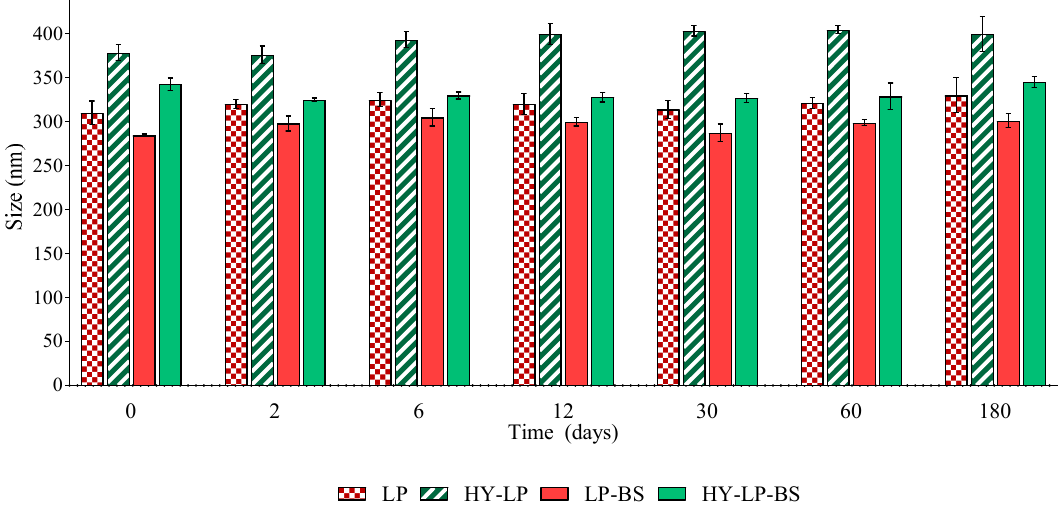
Figure 1. Variation of size of liposomes (LP) and hyalurosomes (HY-LP) with and without biosurfactants (BS) during 180 days of storage at 4-8 °C (mean ± SD, n = 3).